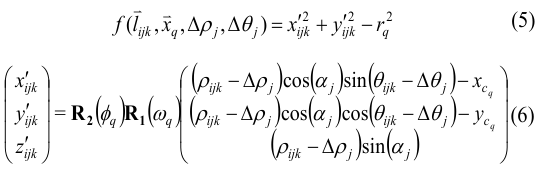
Figure 9. The estimated Δ ρ by the calibration for Dataset 1 over a 10 second period